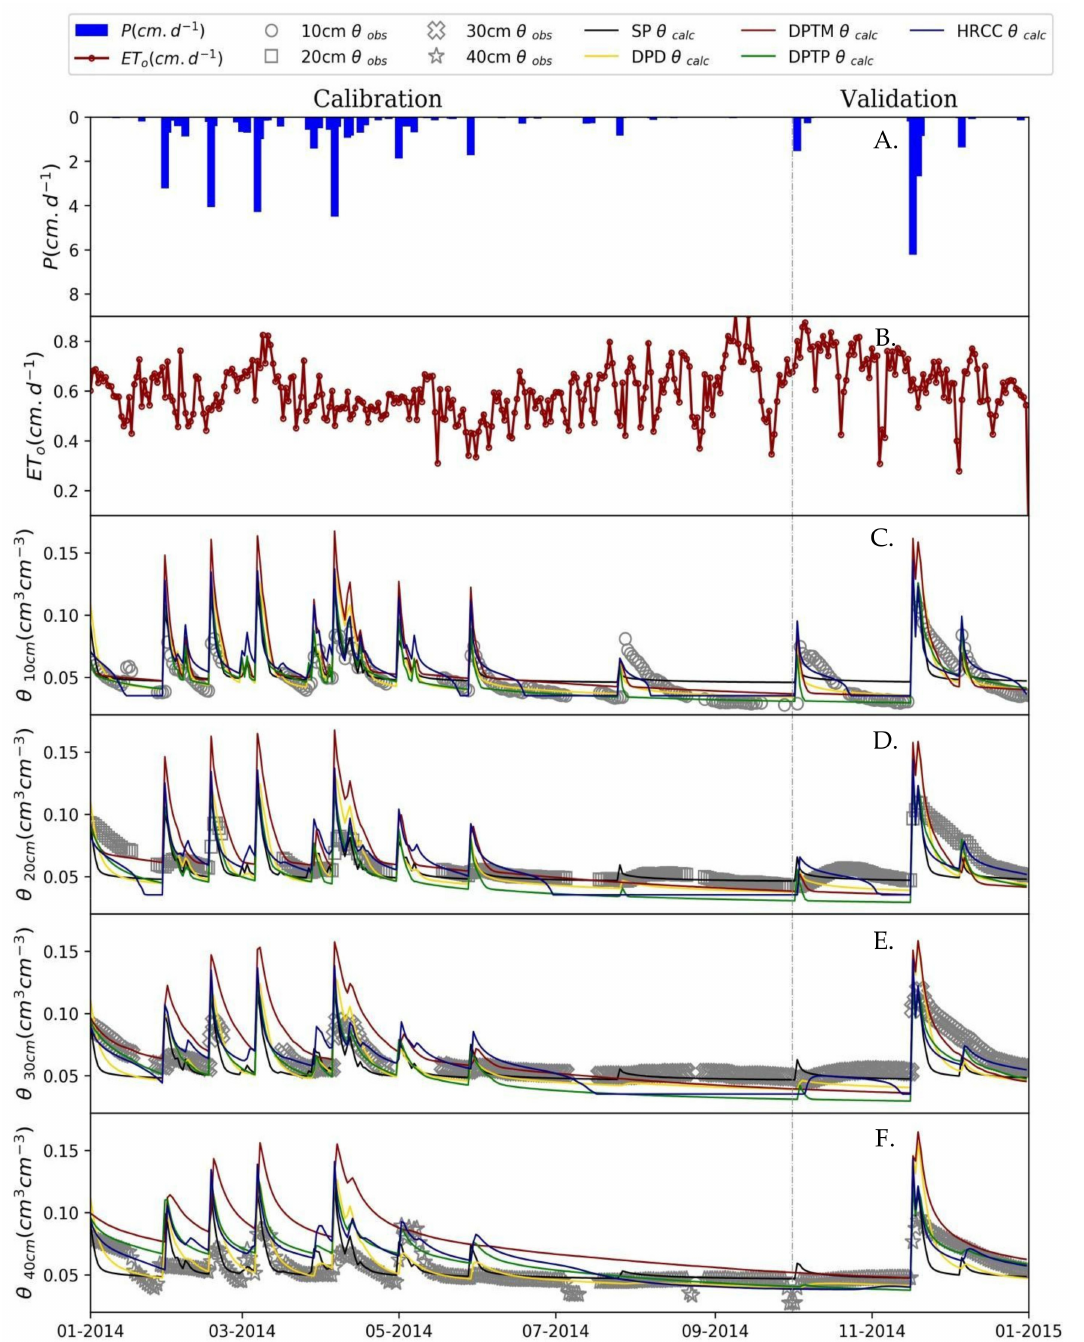
Figure 7. Soil water content observed and simulated by the models in the Pasture area. ( A ). Precipitation; ( B ). Potential Evapotranspiration; ( C ). Soil moisture at 10 cm depth; ( D ). Soil moisture at 20 cm depth; ( E ). soil moisture at 30 cm depth; and ( F ). soil moisture at 40 cm